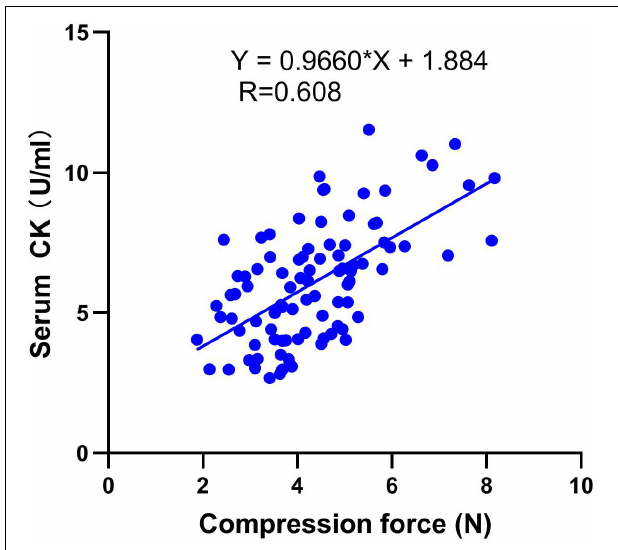
FIGURE 5 | Correlation analysis between serum CK level and compression force ( r = 0.608, P < 0.001). n = 92.